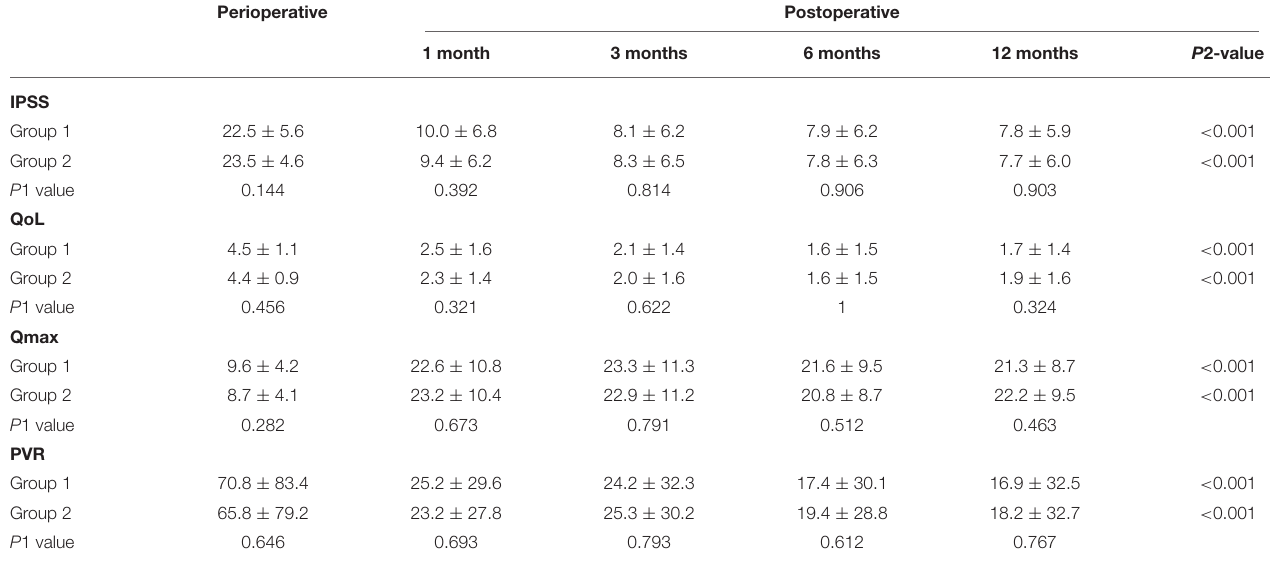
TABLE 3 | Follow-up data for up to 12 months in the two groups.